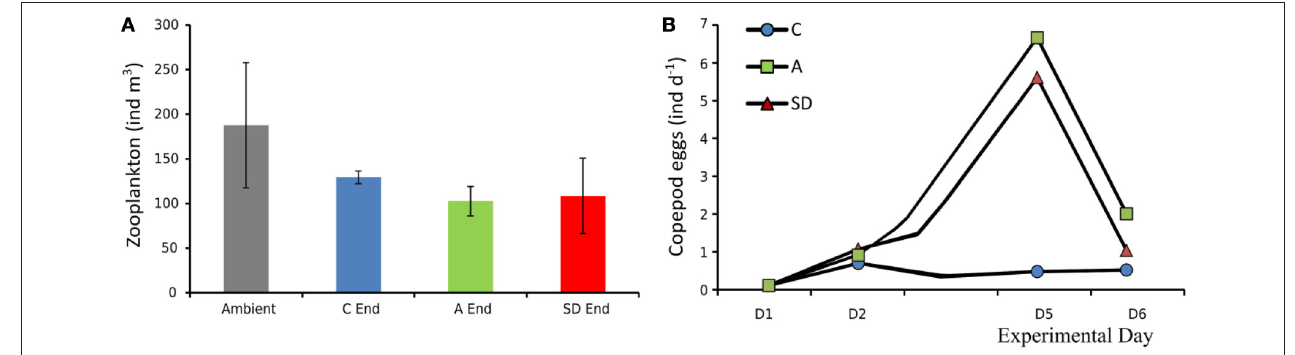
FIGURE 12 | Initial zooplankton abundance (ambient water) and at the end of the experiment (A) , copepod egg production in mesocosms (B)